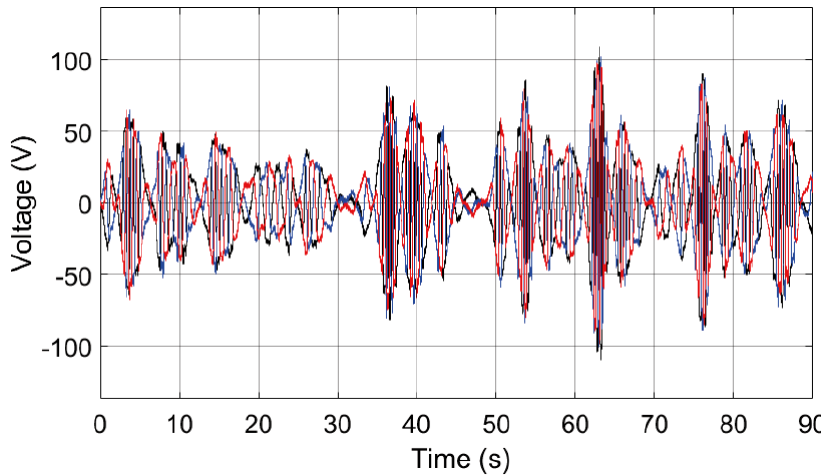
Figure 4. Three-phase voltage output of the linear permanent-magnet generator (LPMG) measured across 4.9 Ω resistive load.